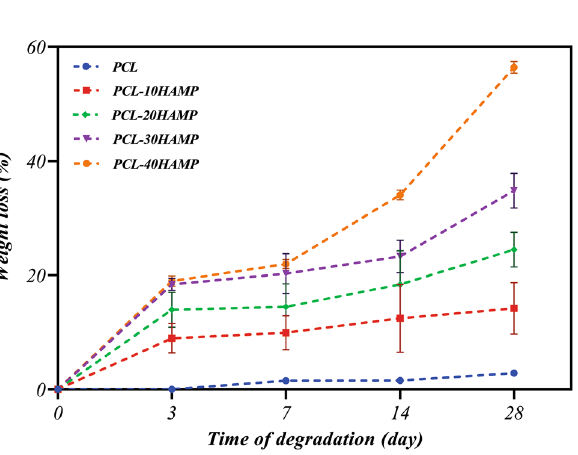
Figure 11. Weight loss percentage curves of the scaffolds after 28 days of immersion in the PBS